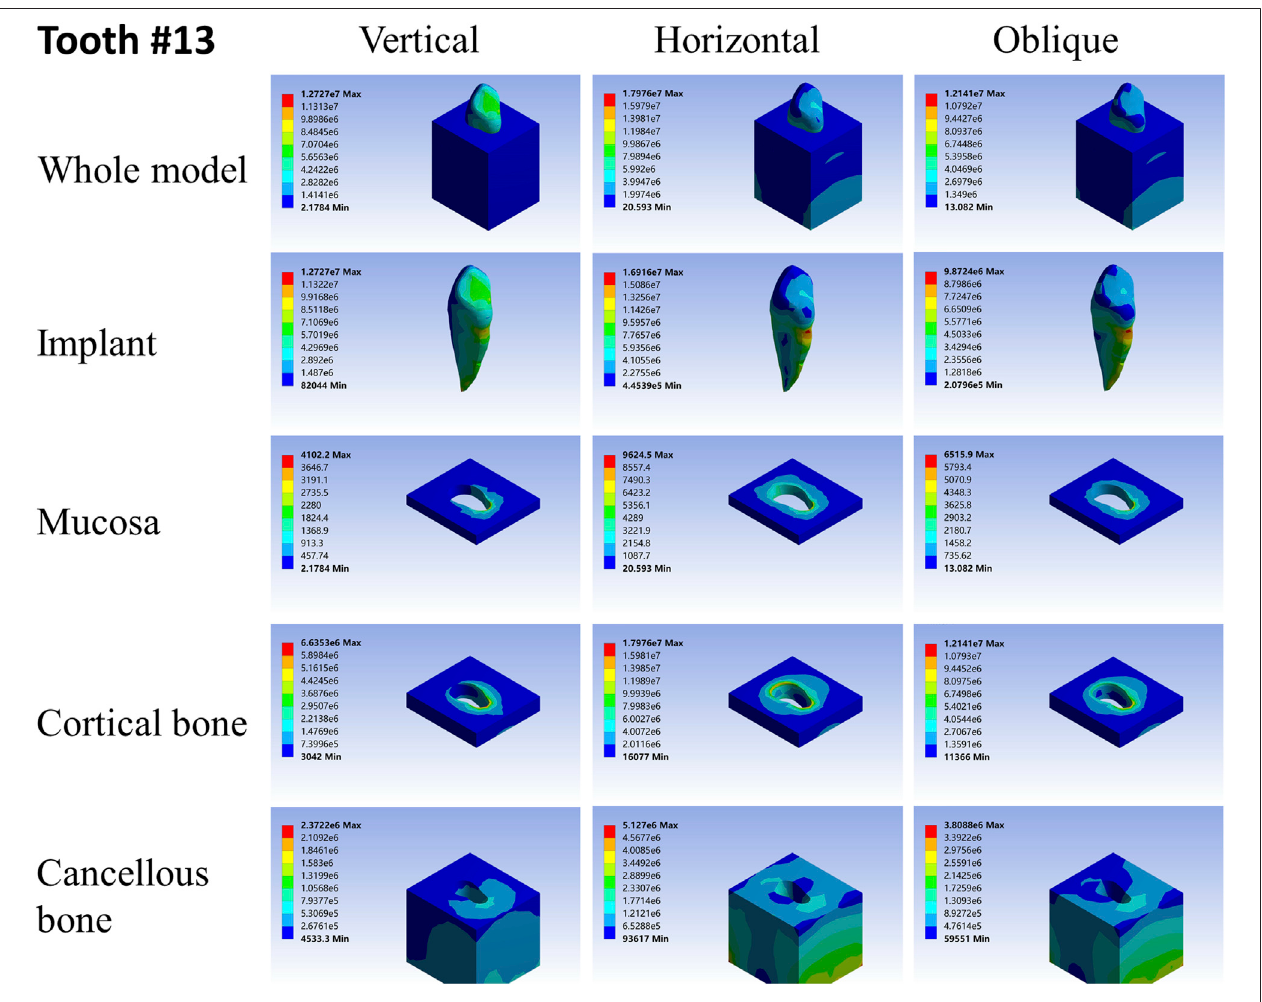
FIGURE 5 | Stress distribution of 13 under 100-N